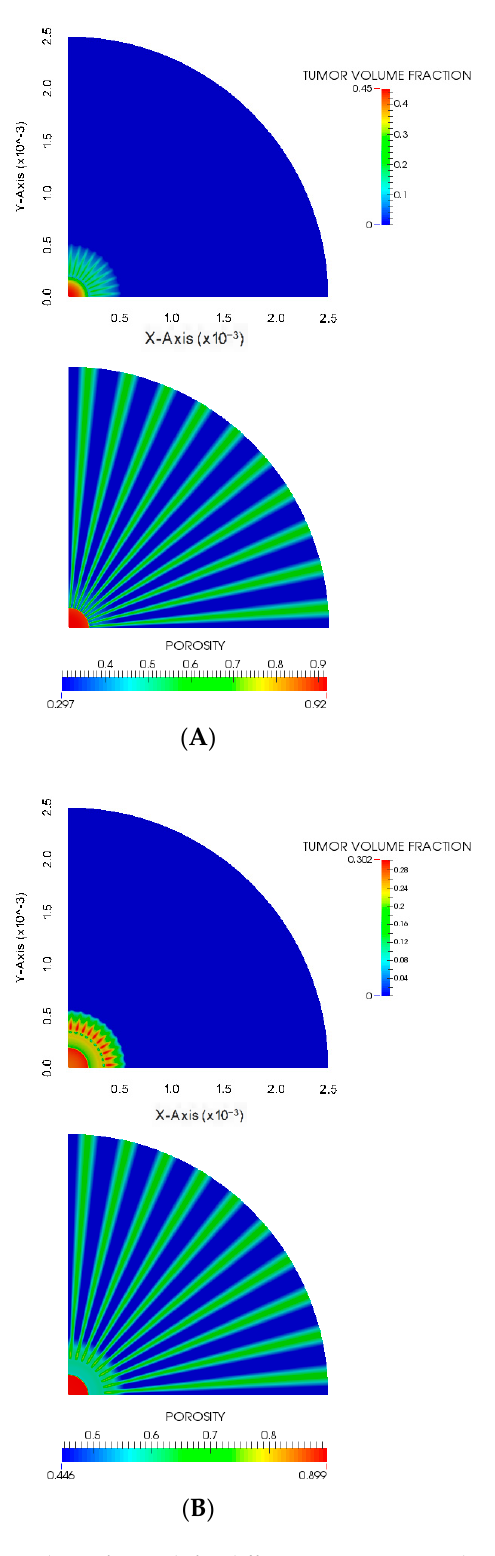
Figure 12. Tumor core after 8 days of growth for different ECM porosity distributions. ( A ) ( top ) Spatial distribution of tumor cells volume fraction in the tumor core for the porosity configuration ε = 0.3/0.85 after 8 days; ( below ) porosity distribution at the same time instant. ( B ) ( top ) Spatial distribution of tumor cells volume fraction in the tumor core for the porosity configuration ε = 0.5 + 0.3/0.85 after 8 days; ( below ) porosity distribution at the same time instant. A more developed heterogeneity can be seen in ( B ), in line with what was expected from Figure 4A. The outer part is occupied by the corona which has a much lower density and does not appear in the image.